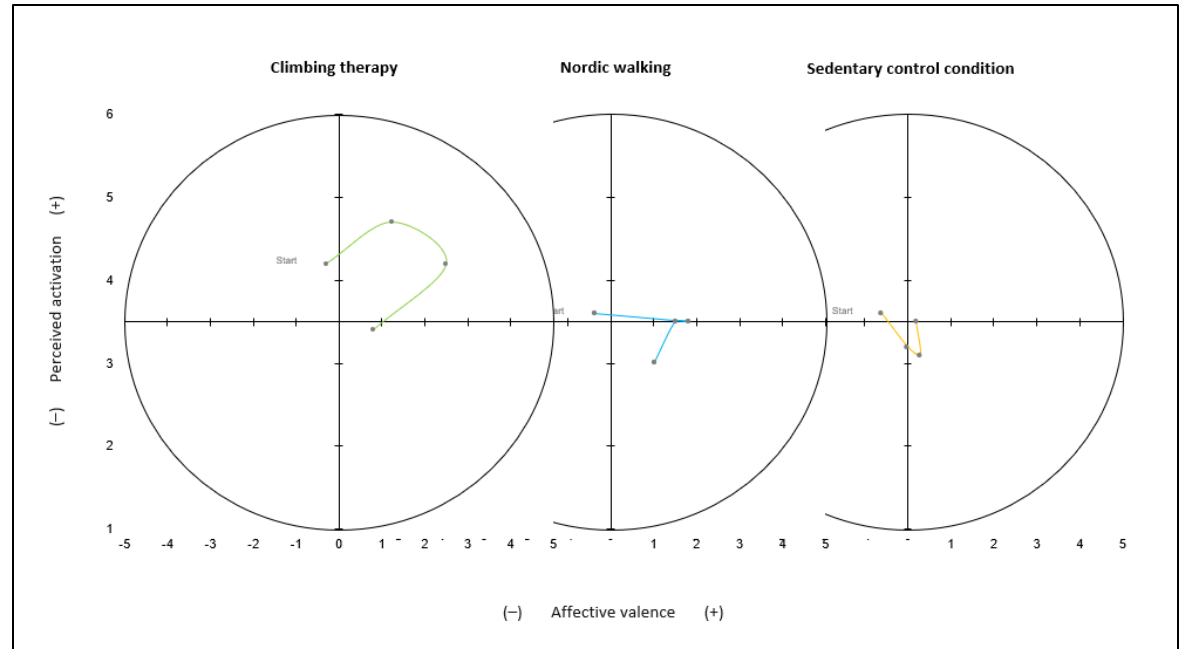
Figure 3. Mean affective valence and perceived activation over time for all the three interventions and 4 points in